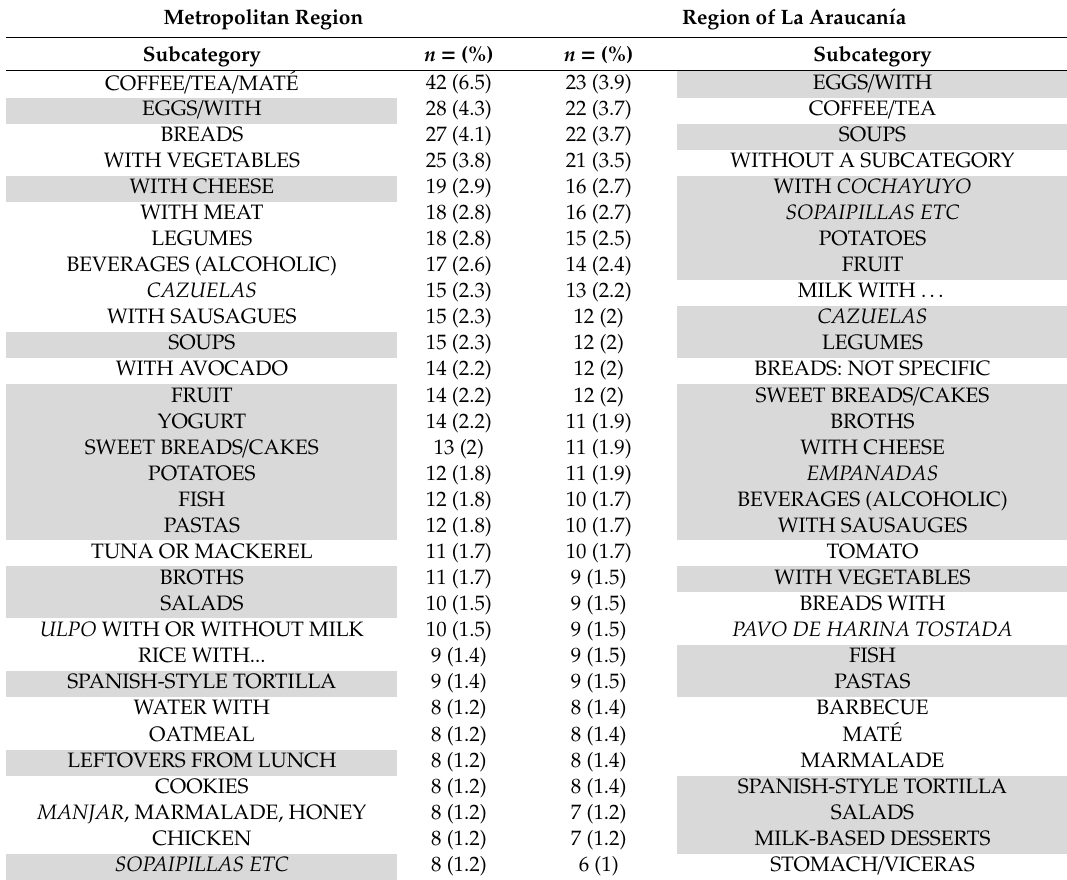
Table 4. Frequency of traditional culinary preparations mentioned during the community workshops by region †